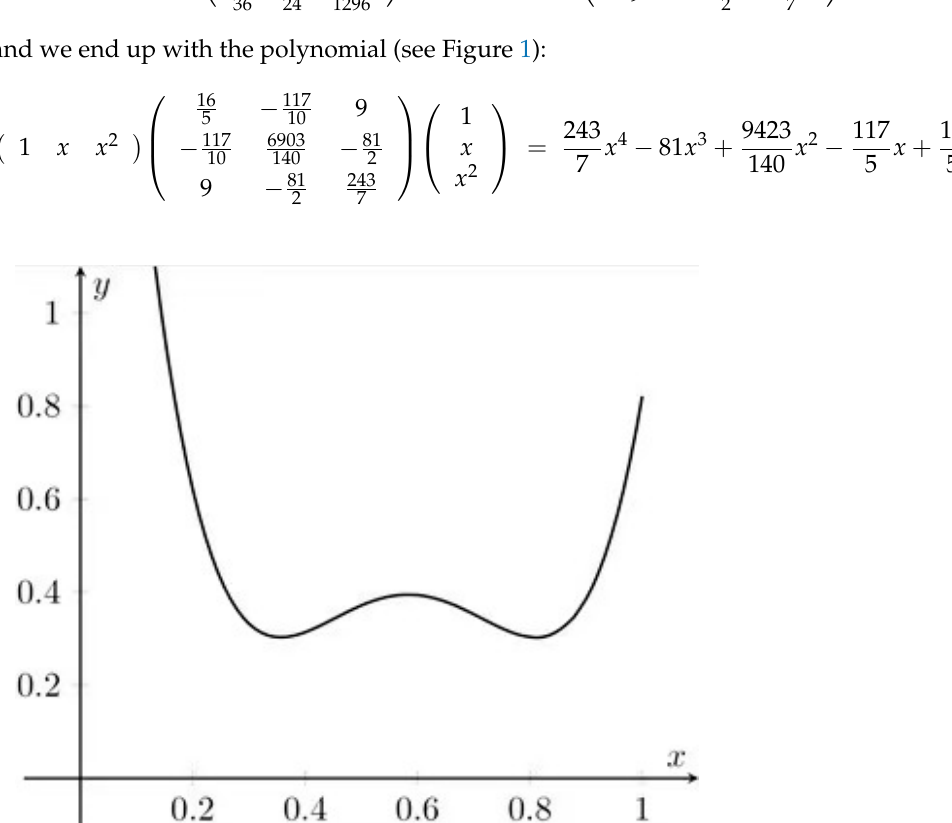
Figure 1. An example of prediction uncertainty pattern for quadratic regression in calibration.